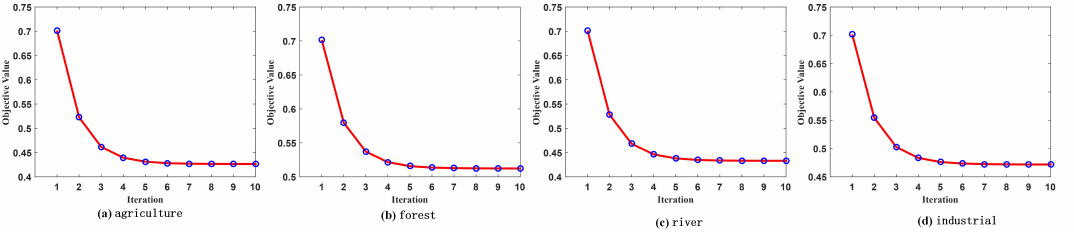
Figure 10. Illustration of the convergence of the SMRMKL learning algorithm for four